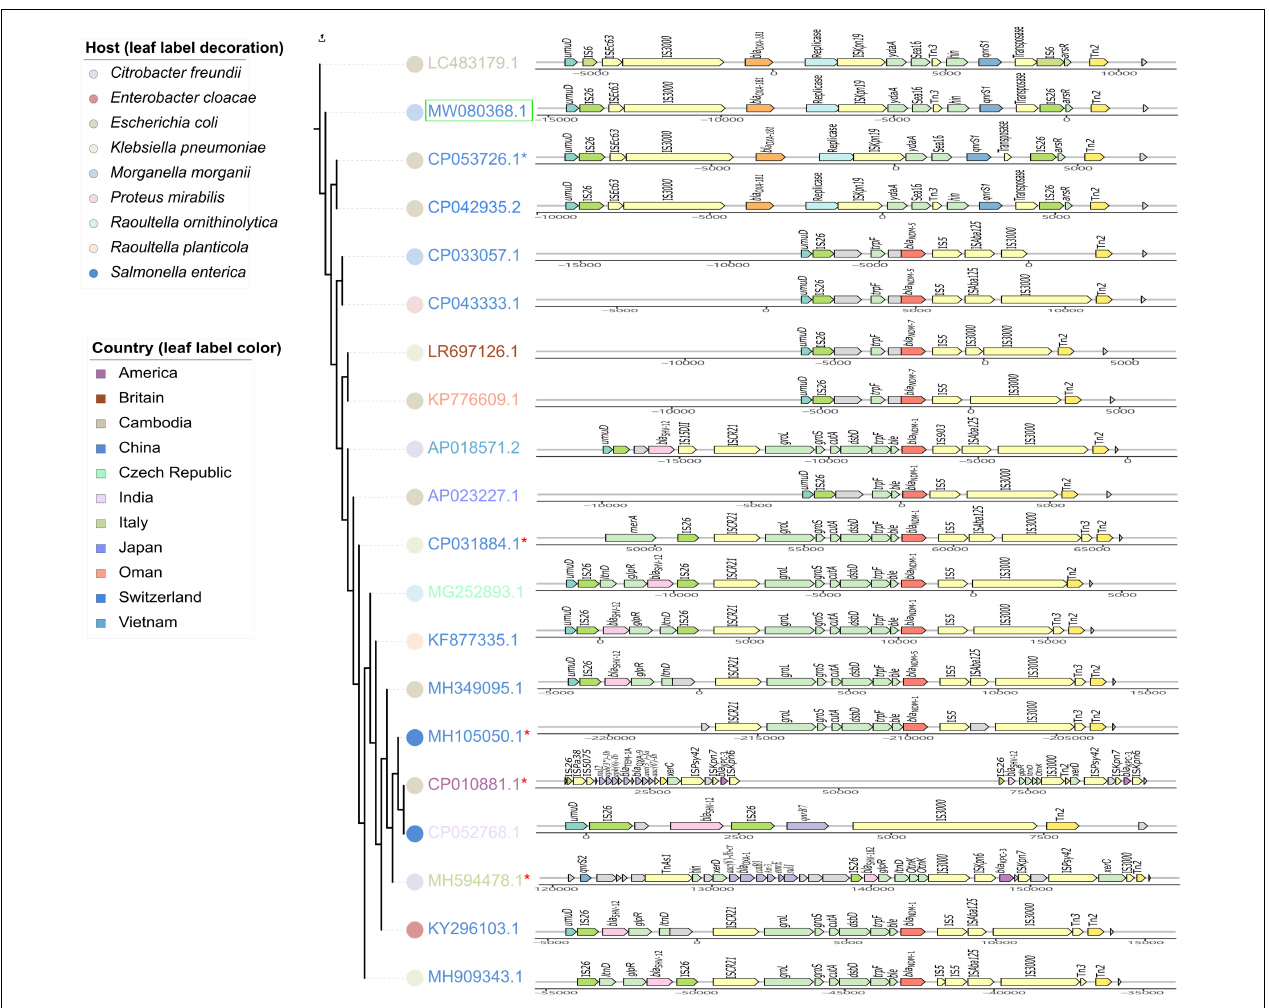
FIGURE 4 | Phylogenetic analysis of IncX3 plasmids combined with the comparisons of their resistance regions. Branch length represents genetic variabilities. Genes and ORFs are shown as arrows without orientations. The colors of symbols beside leaf labels indicate bacterial hosts of these plasmids and leaf label colors represent geographic origins. pZYM28-OXA-181 in this study is noted with a green hollow rectangle. Cointegrate plasmids consisting of IncX3 and other type of plasmid backbones are noted with red *. The resistance regions comparisons were drawn with gggenes aligned with bla NDM